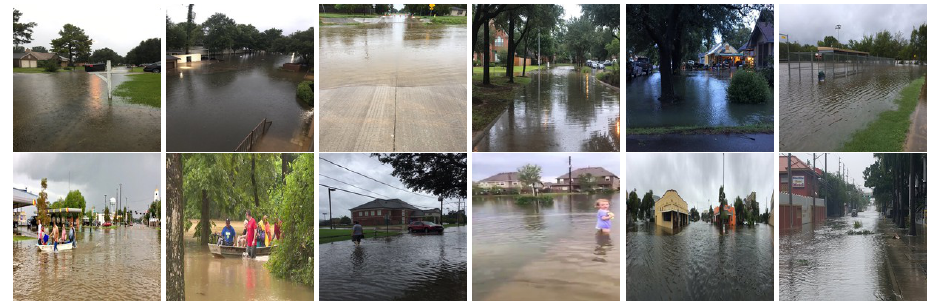
Figure 7. Top 12 images correctly retrieved by VRBagged-Net for the dataset of FCSM.